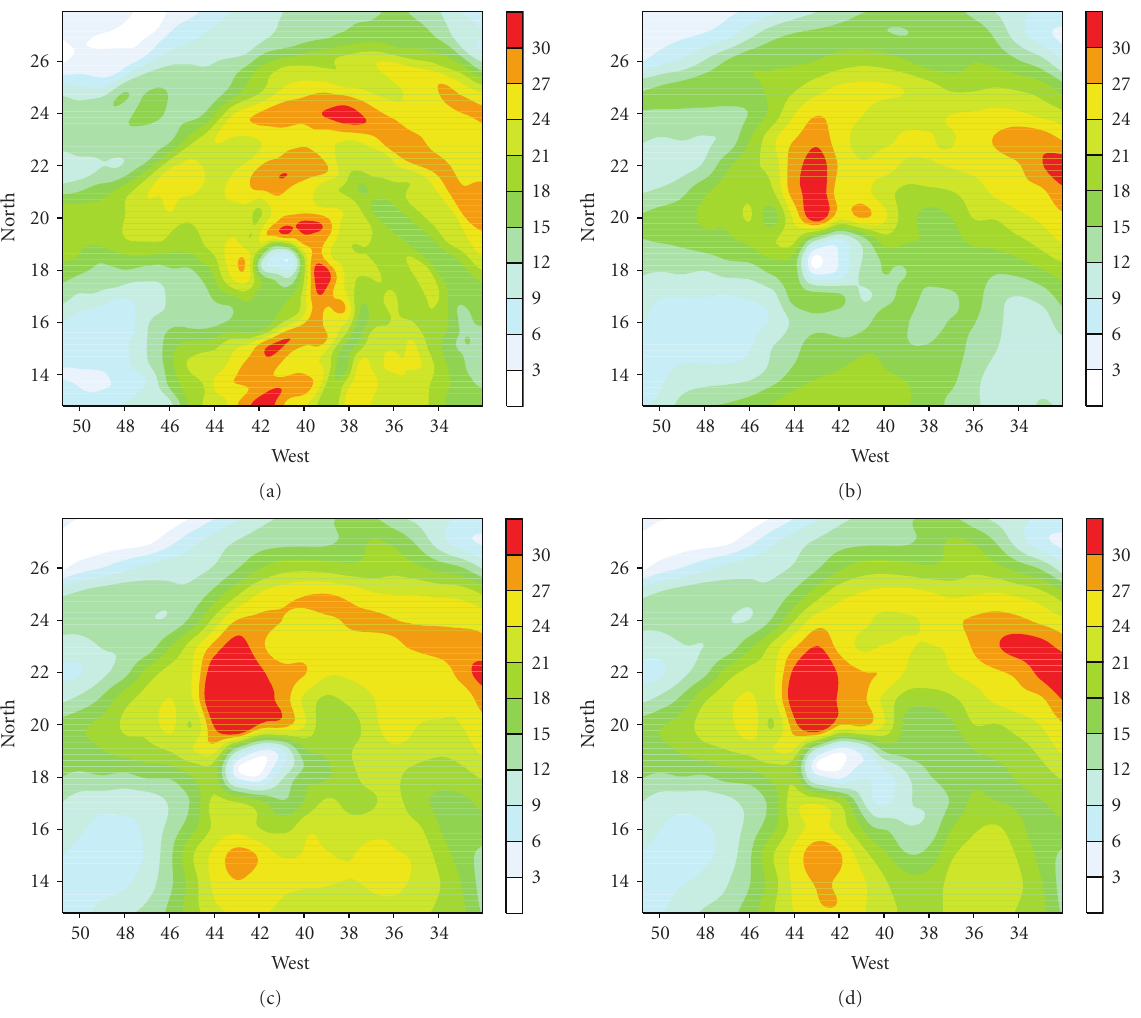
Figure 4: The wind shear (units: ms − 1 ) between 850hPa and 200 hPa at 0600 UTC 01 October 2005 from (a) regional nature run, (b) control run, (c) data assimilation Experiment 1, and (d) data assimilation Experiment